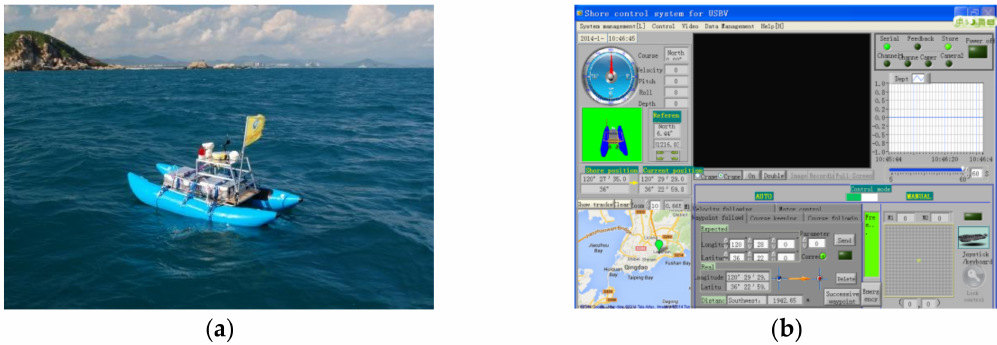
Figure 4. ( a ) Unmanned Surface Bathymetry Vehicle (sea trial around Wuzhizhou Island, 2016); and ( b ) shore control software interface of the